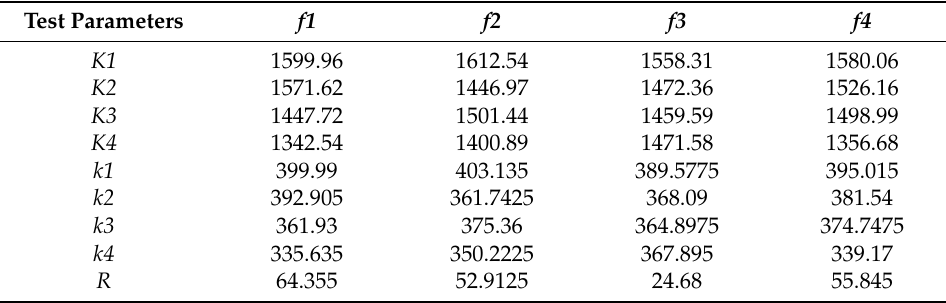
Table 7. Results of the surface hardening extreme analysis.